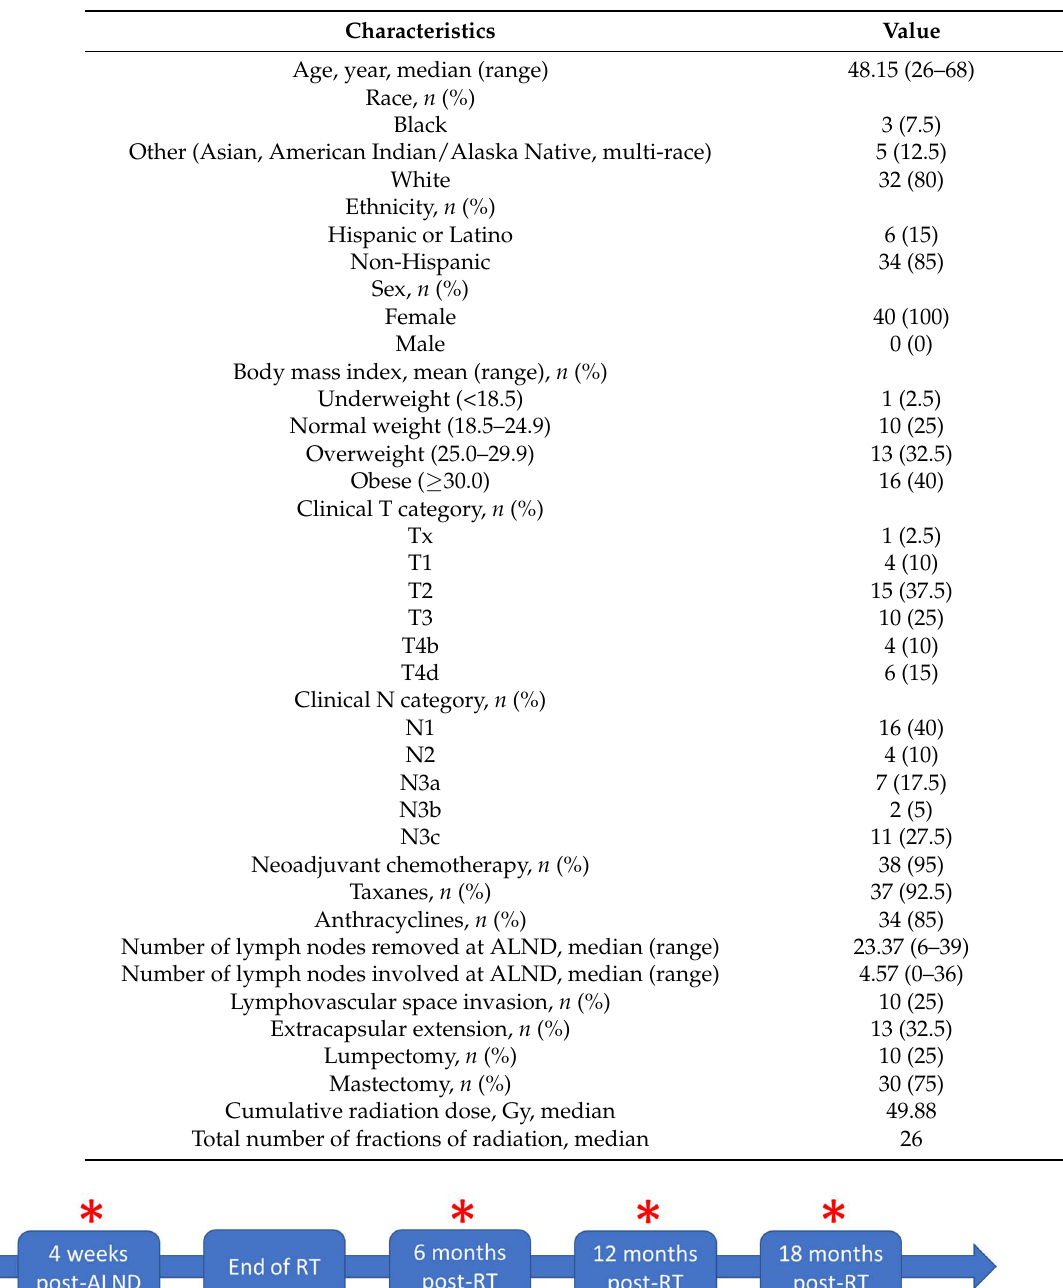
Table 1. Study subject demographics.